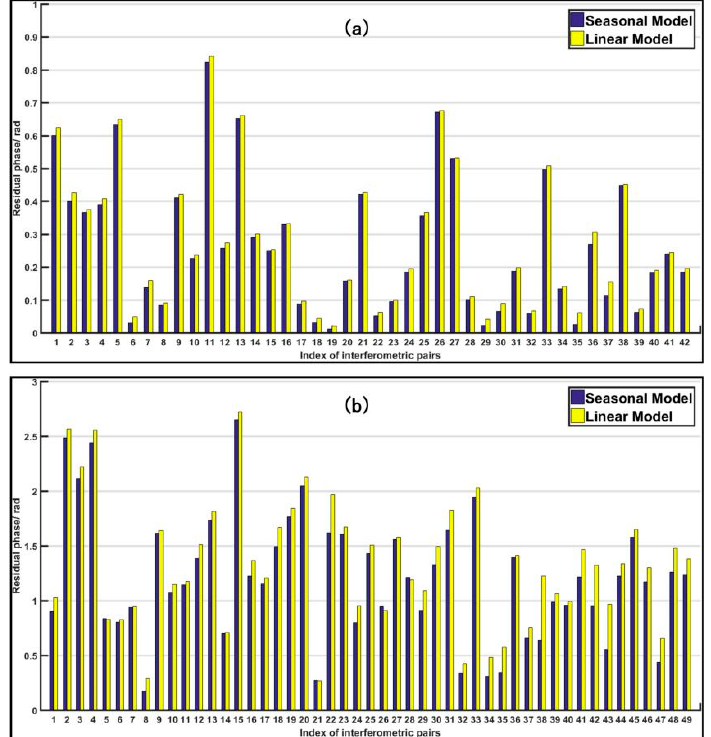
Figure 18. The residual phase comparison. ( x axis represents the index of interferograms; y axis represents the mean residual phase for all coherent points.) ( a ) Lungui Highway; ( b ) G1501 Highway.